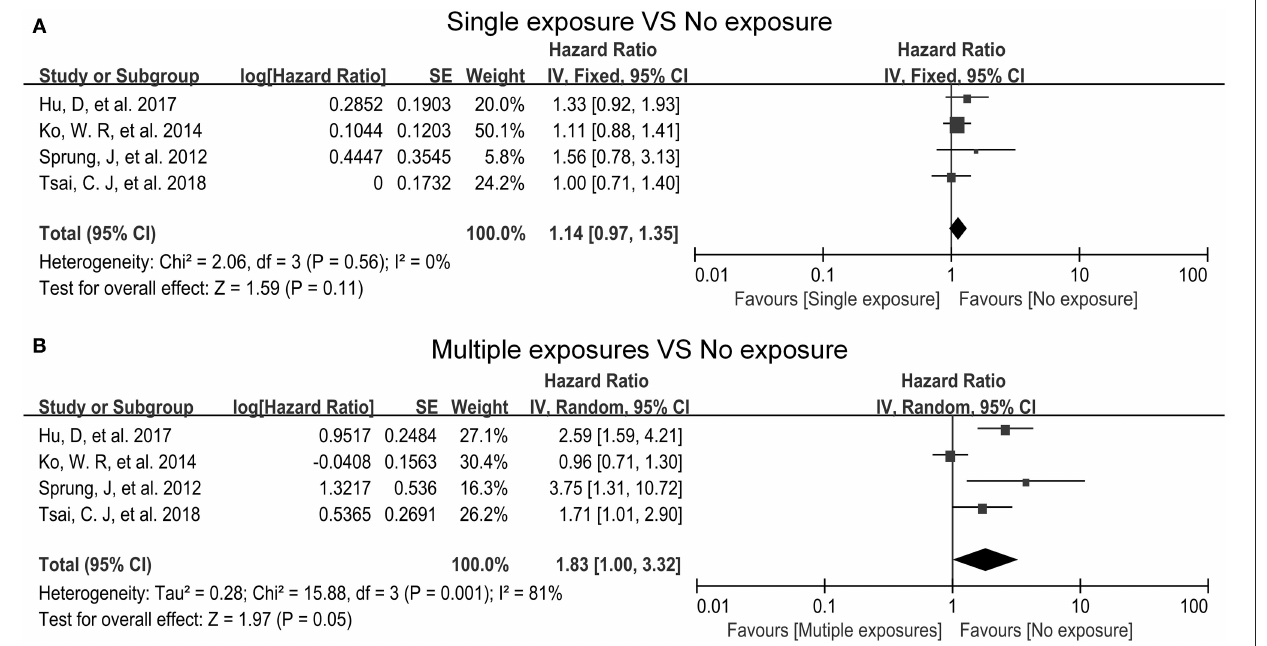
congenital anomalies (10). Data in the study of Spruing